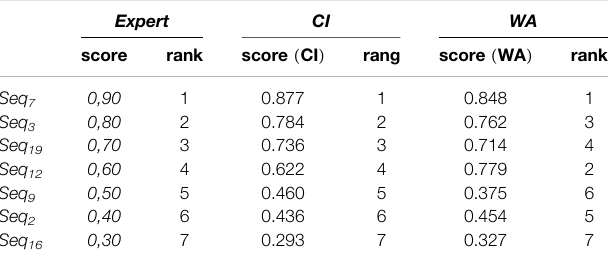
TABLE 7 | Comparison of scores for the learning subset given by the expert, CI, and WA.